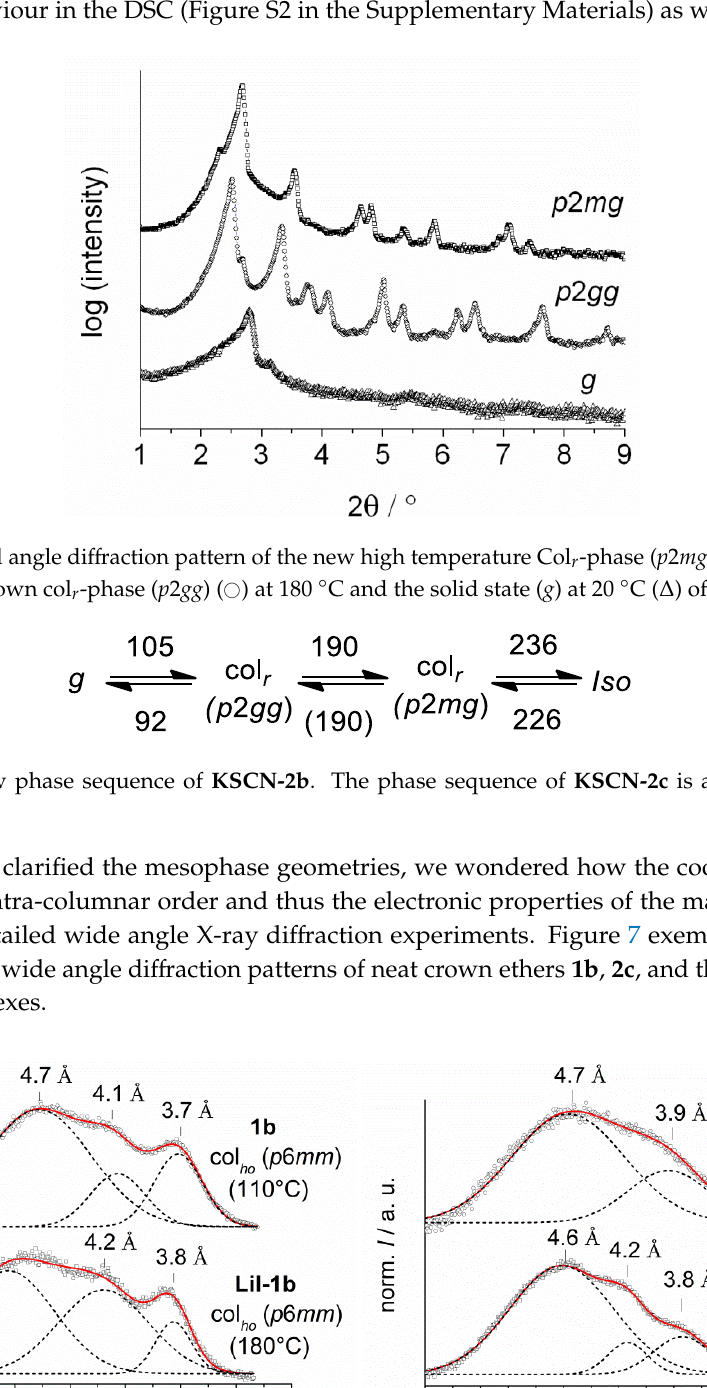
Figure 7. Wide angle diffraction patterns of 1b vs. LiI-1b (top) and 2c vs. KSCN-2c (bottom). An additional peak can be observed in the diffraction pattern of KSCN-2c due to the ion coordination. The dotted curves divide the scattering pattern in single Gaussian distribution functions.